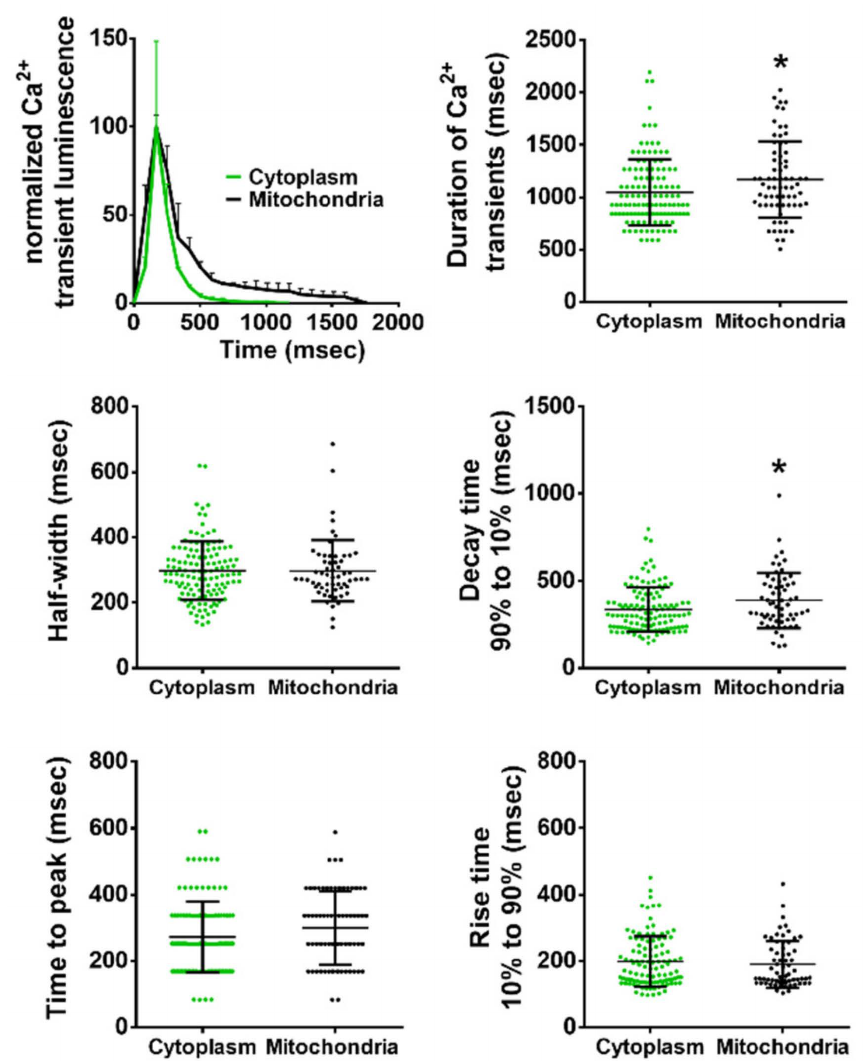
Figure 7. Comparison of the kinetic parameters of cytosolic and mitochondrial Ca 2 + transients in zebrafish trunk in embryos expressing GA and mitoGA. Ca 2 + transients in cytoplasm and mitochondria were compared. Embryos were imaged at 11.9 Hz. A two-tailed unpaired t -test was used. Shown as mean ± S.D. ( n = 128 transients from 3 embryos for GA, green points; n = 71 transients from three embryos for mitoGA, black points). Statistical significance was considered for * p <